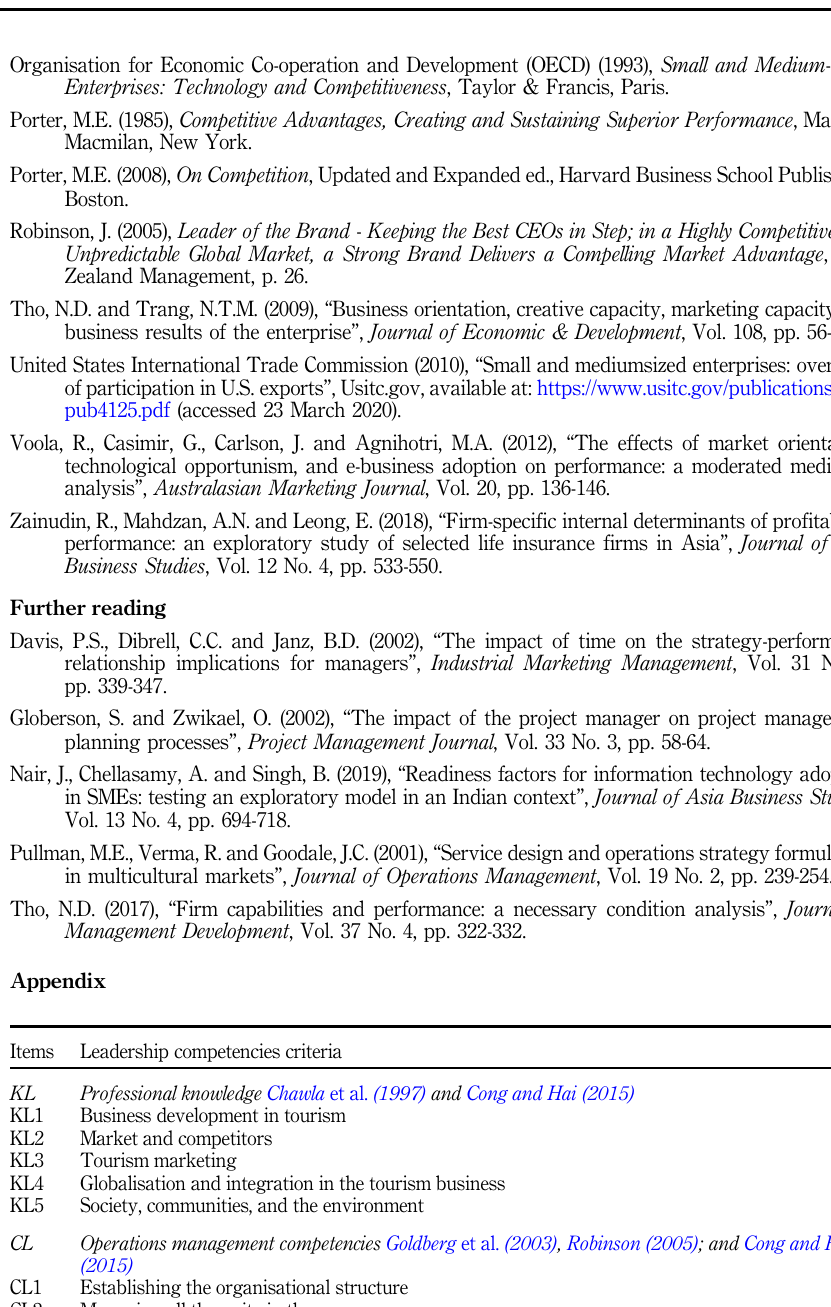
Table A1. Variables of leadership competencies in the research